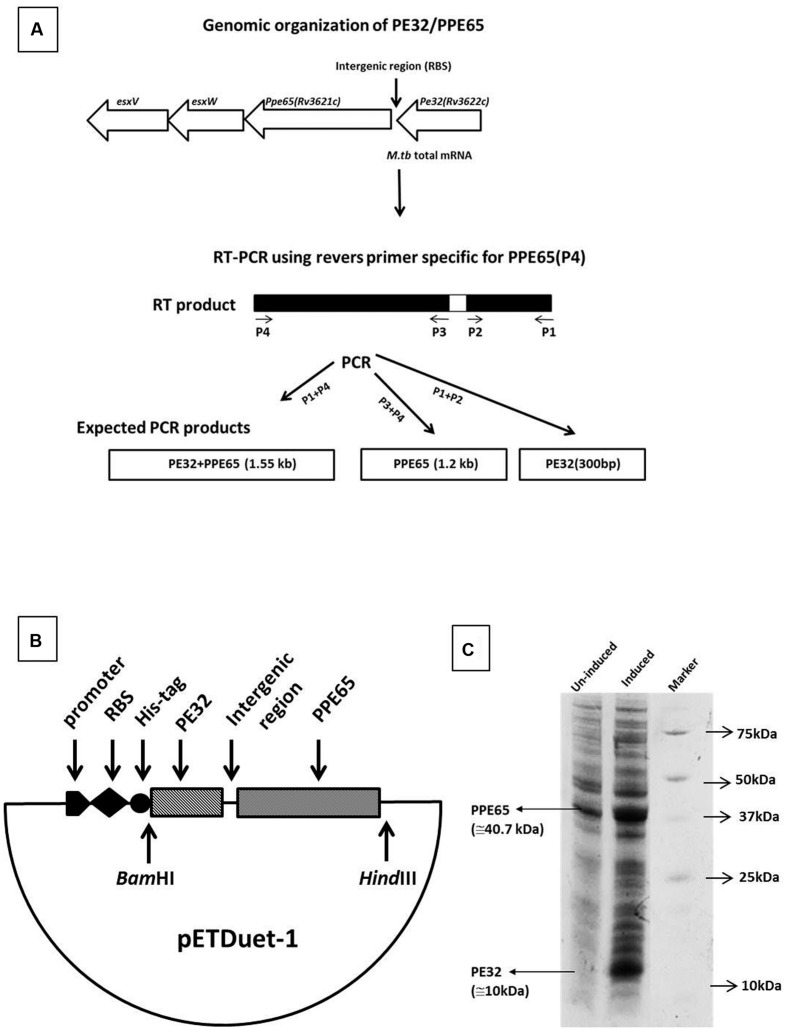
Genomic organization and expression analysis reveals PE32 and PPE65 as functionally linked co-operonic gene pair.
PE32/PPE65 (Rv3622c/Rv3621c) gene pair is organized in an operon. (A) Schematic representation of co-operonic genes. Primer pair specific to PE32 produced amplicon of the size 300 bp, specific primer pair for PPE65 yielded amplification of 1.2 kb, and forward primer for PE32 and reverse primer for PPE65 revealed an amplification product of 1.5 kb. (B) Schematic representation of clone of PE32 + PPE65 gene pair as single operon. (C)
PE32/PPE65 genes are expressed together at protein level. Expression of PE32/PPE65 gene was checked on 10% tricine SDS gel. Lane 1 is un-induced culture, Lane 2 is induced culture showing the expression of PE32 (10 kDa) and PPE65 (40.7 kDa), Lane 3 is protein ladder.